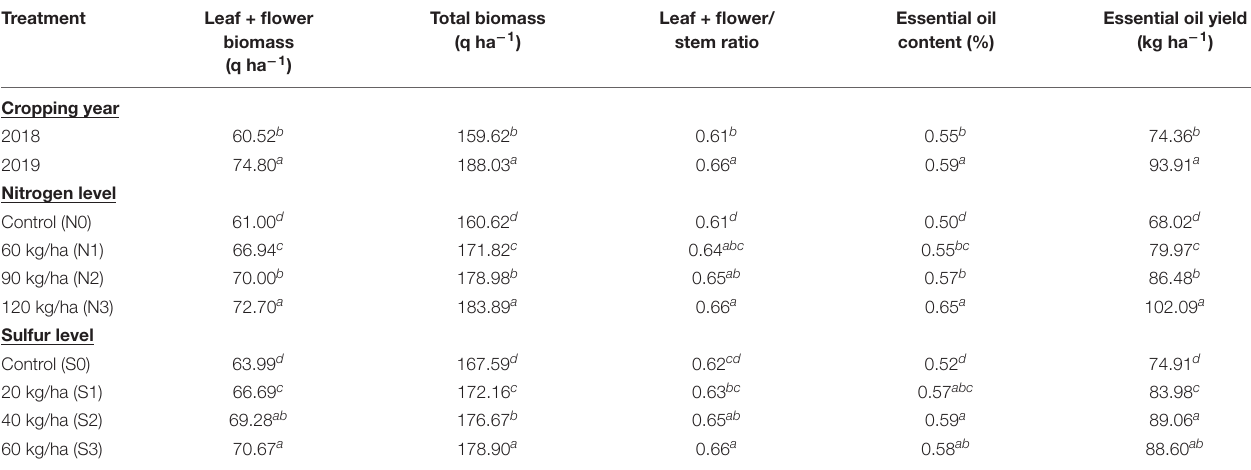
TABLE 3 | Effect of year and fertilization levels on biomass and essential oil yield of T. minuta . Treatment